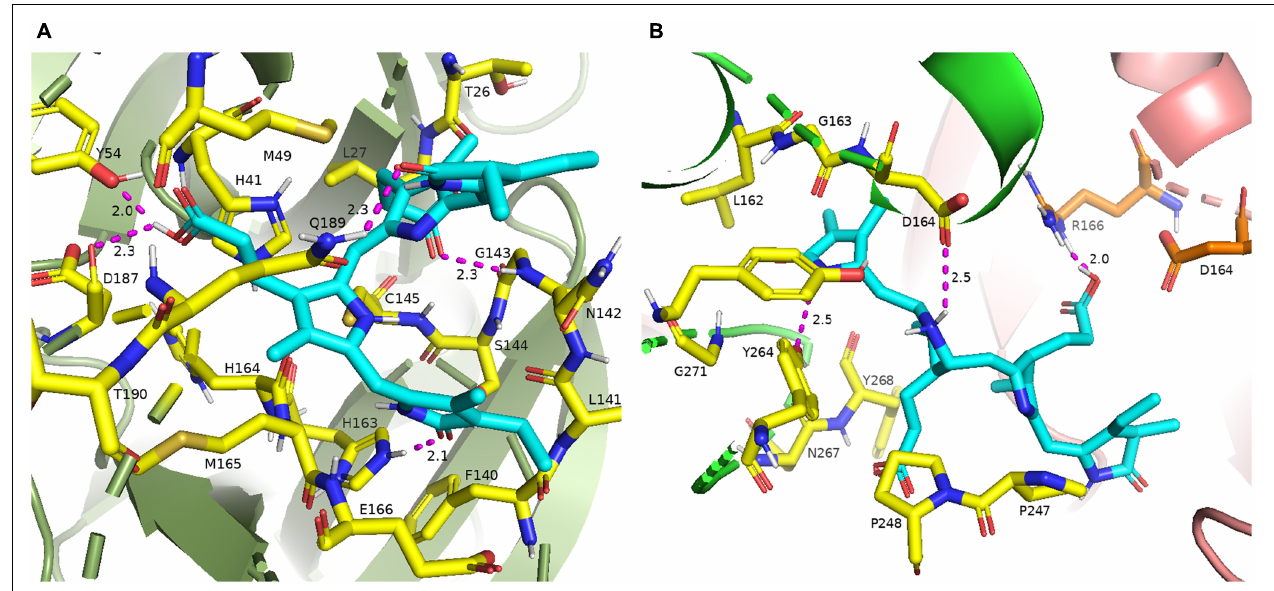
FIGURE 1 | (A) 3-D binding pocket of SARS-CoV-2 M pro with top model PCB (cyan color), surrounding active site amino acid residues (yellow color) within 3 Å; remaining residues are represented as a cartoon; (B) 3-D binding pocket of SARS-CoV-2 PL pro with top model PCB (cyan color), surrounding active site amino acid residues (chain A, yellow color; chain B, orange color) within 3 Å; remaining residues are represented as a cartoon (chain A, green color; chain B, light pink color). Polar interactions are represented as magenta